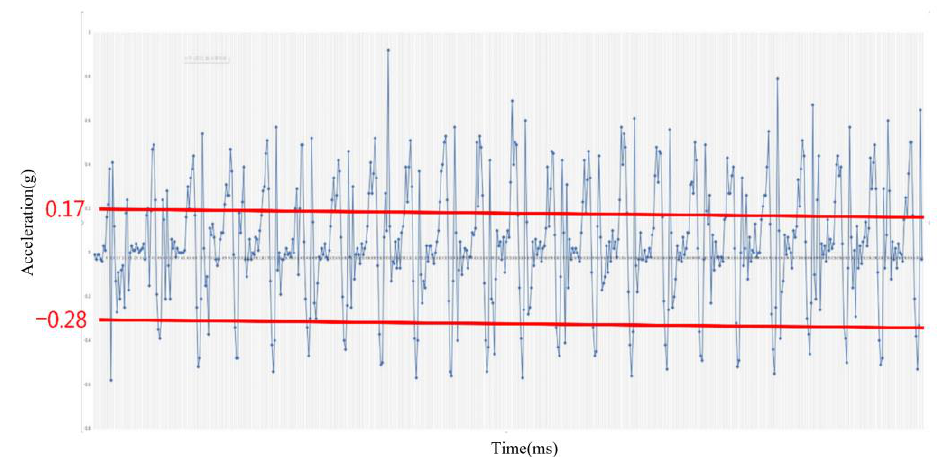
Figure 14. Acceleration for step count.